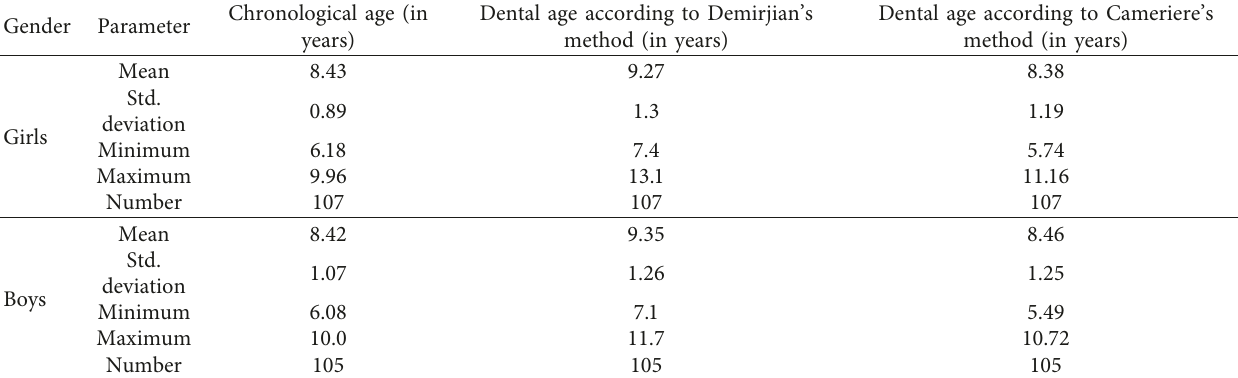
Table 1: Measures of central dispersion for the chronological age and dental age of girls and boys according to Demirjian’s and Cameriere’s methods.